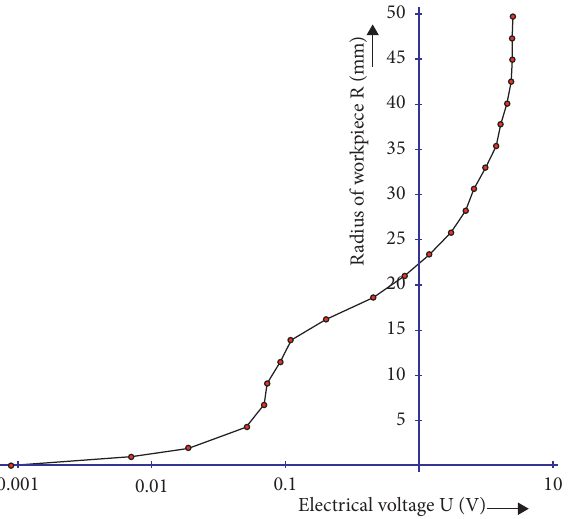
Figure 8: Graphical plot of transfer R � f ( U ) on a logarithmic scale.